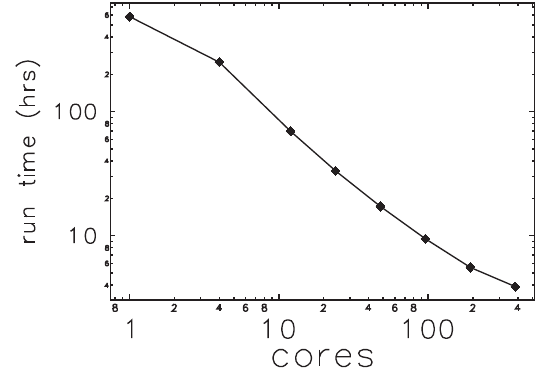
FIG. 1. Run time vs number of processors for a typical APS simulation (1000 turns).